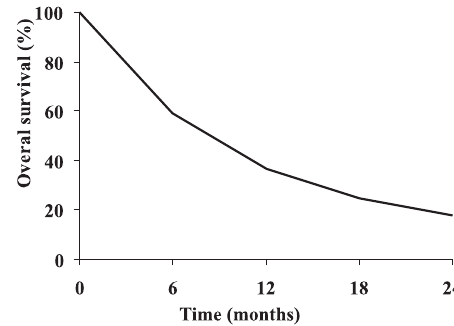
Figure 1 – Overall survival for all patients included in the